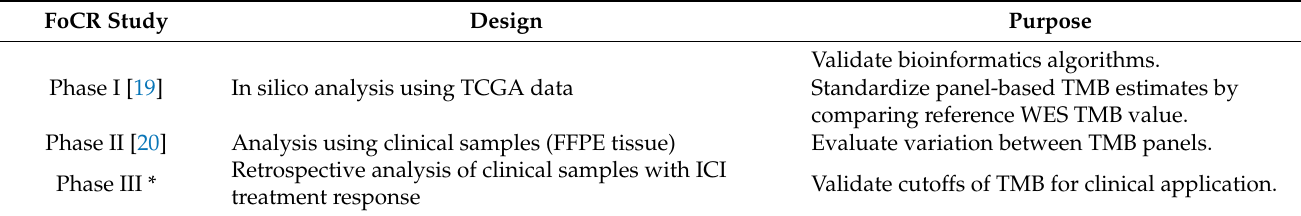
Table 1. Design and purposes of FoCR harmonization